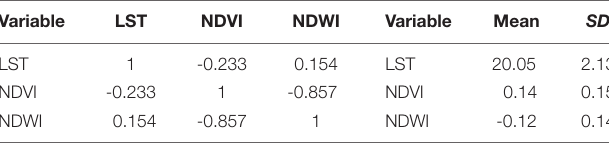
TABLE 4 | Pearson’s correlation and descriptive statistics.